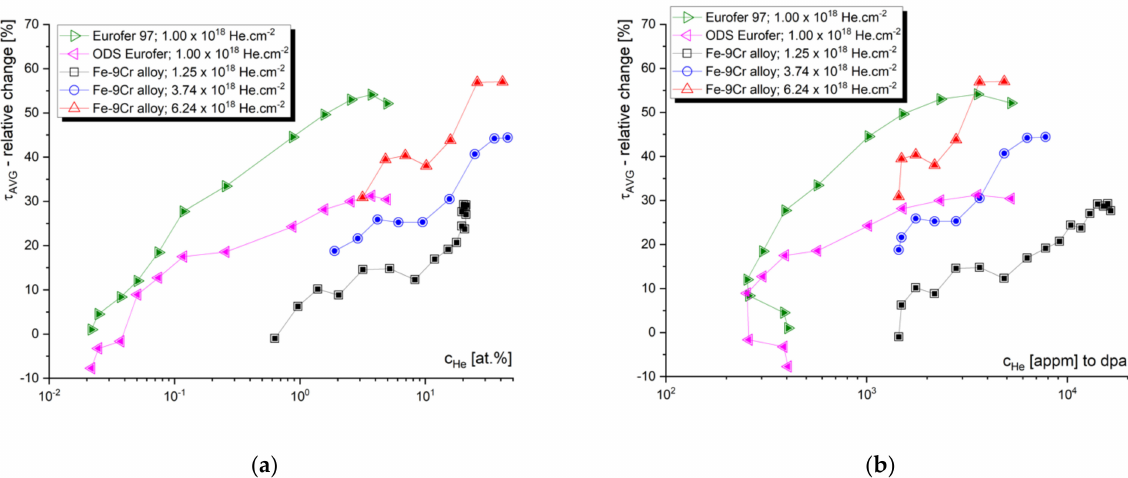
Figure 9. Relative increase in the average positron lifetime as obtained for the investigated samples. Data are plotted as a function of helium concentration c He ( a ) and as a function of helium/dpa ratio ( b